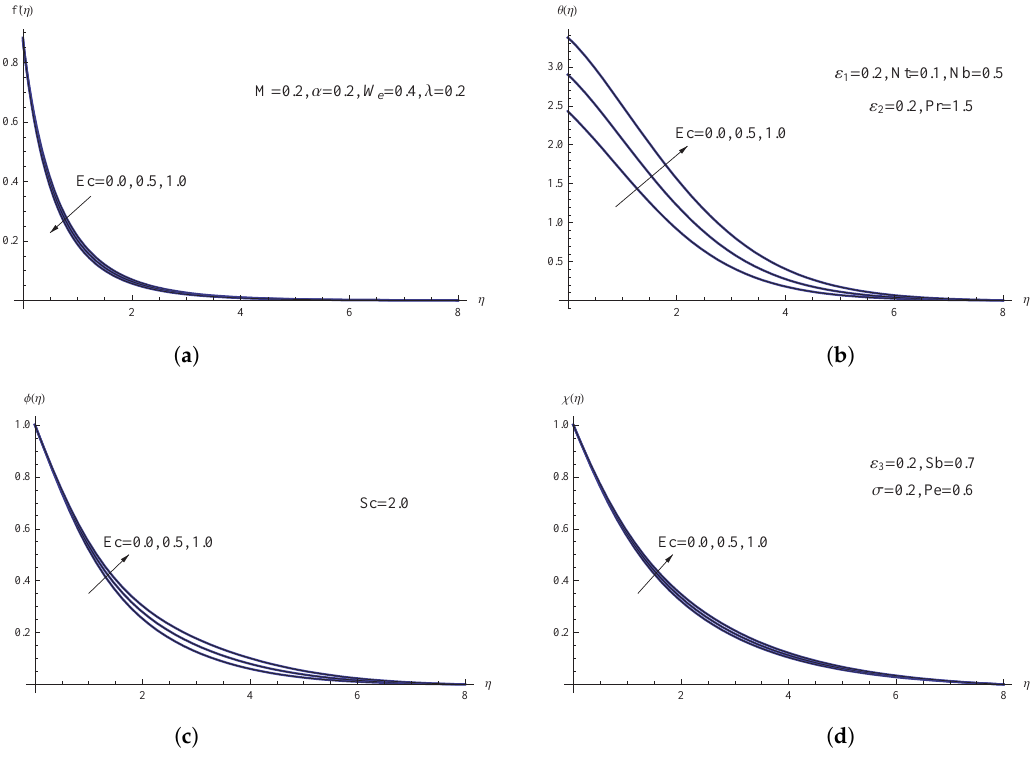
Figure 8. ( a ) f (cid:48) ( η ) for various Ec . ( b ) θ ( η ) for various Ec . ( c ) φ ( η ) for various Ec . ( d ) χ ( η ) for various Ec